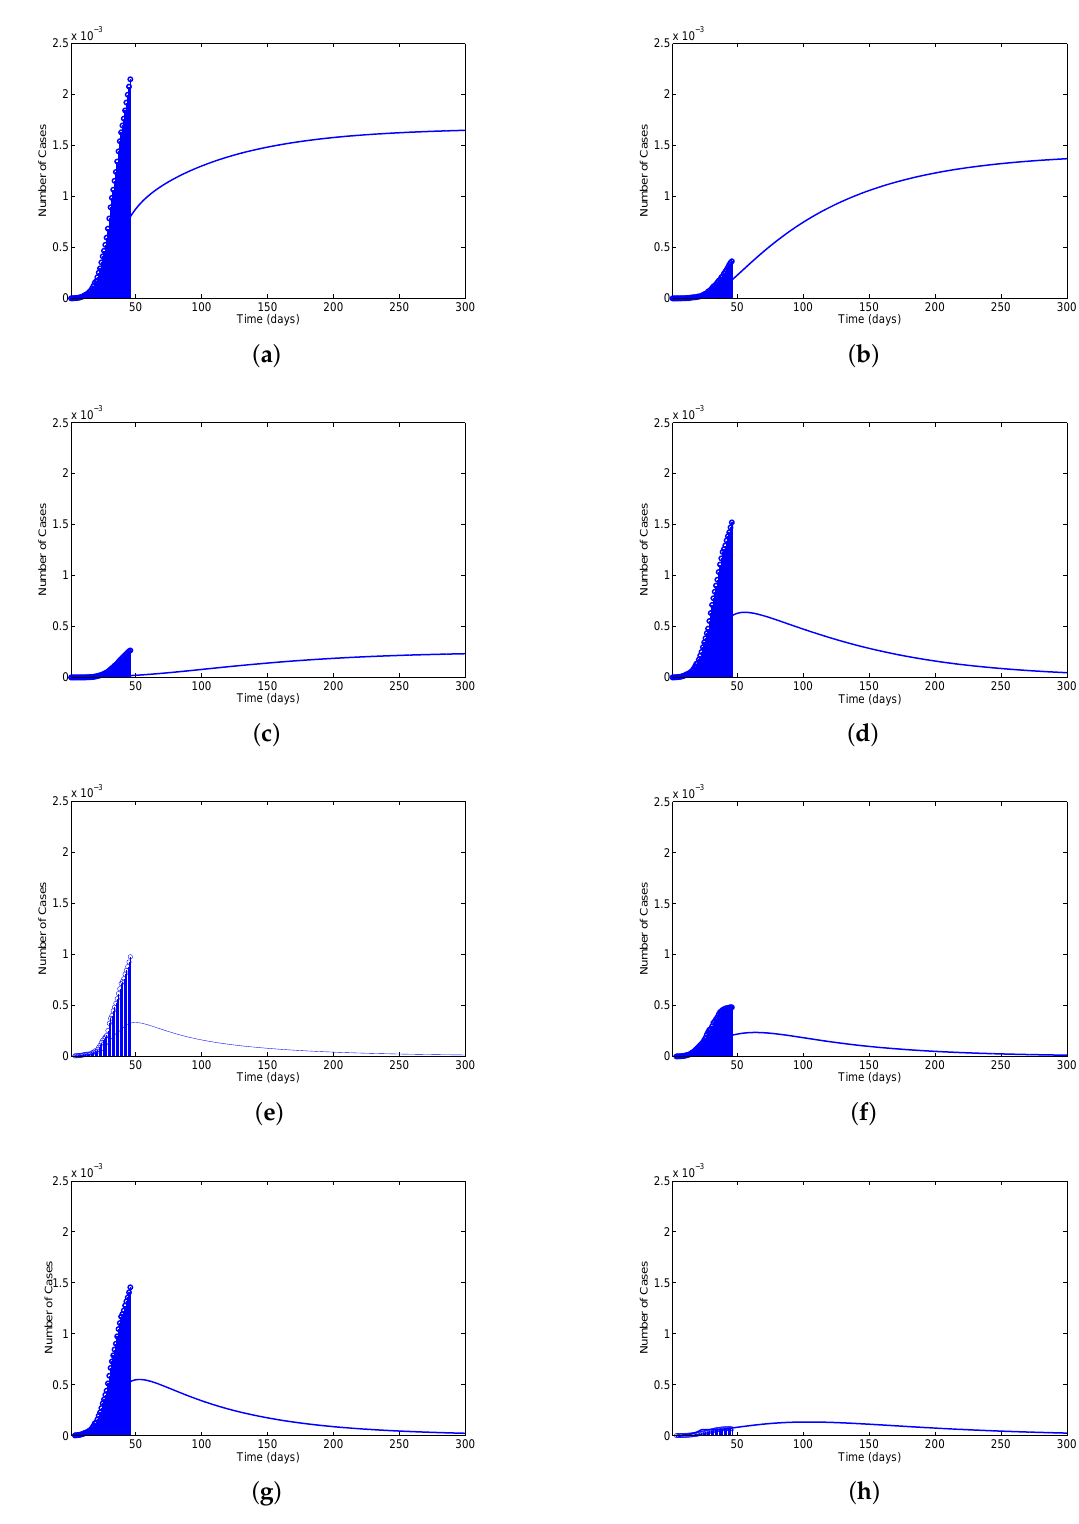
Figure 6. The basic reproduction number calculated from number of cases on real life data, ( a ) number of cases 80% increased, ( b ) number of cases 20% increased, ( b ) number of cases 10% increased, ( d ) number of cases 60% increased, ( e ) number of cases 40% increased, ( f ) number of cases 20% increased, ( g ) number of cases 60% increased, ( h ) number of cases 5%